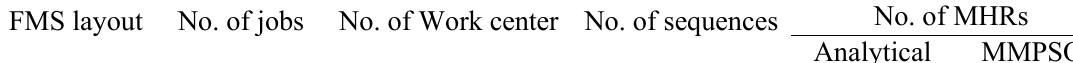
MHRs fleet size by the MMPSO algorithm and the analytical model.